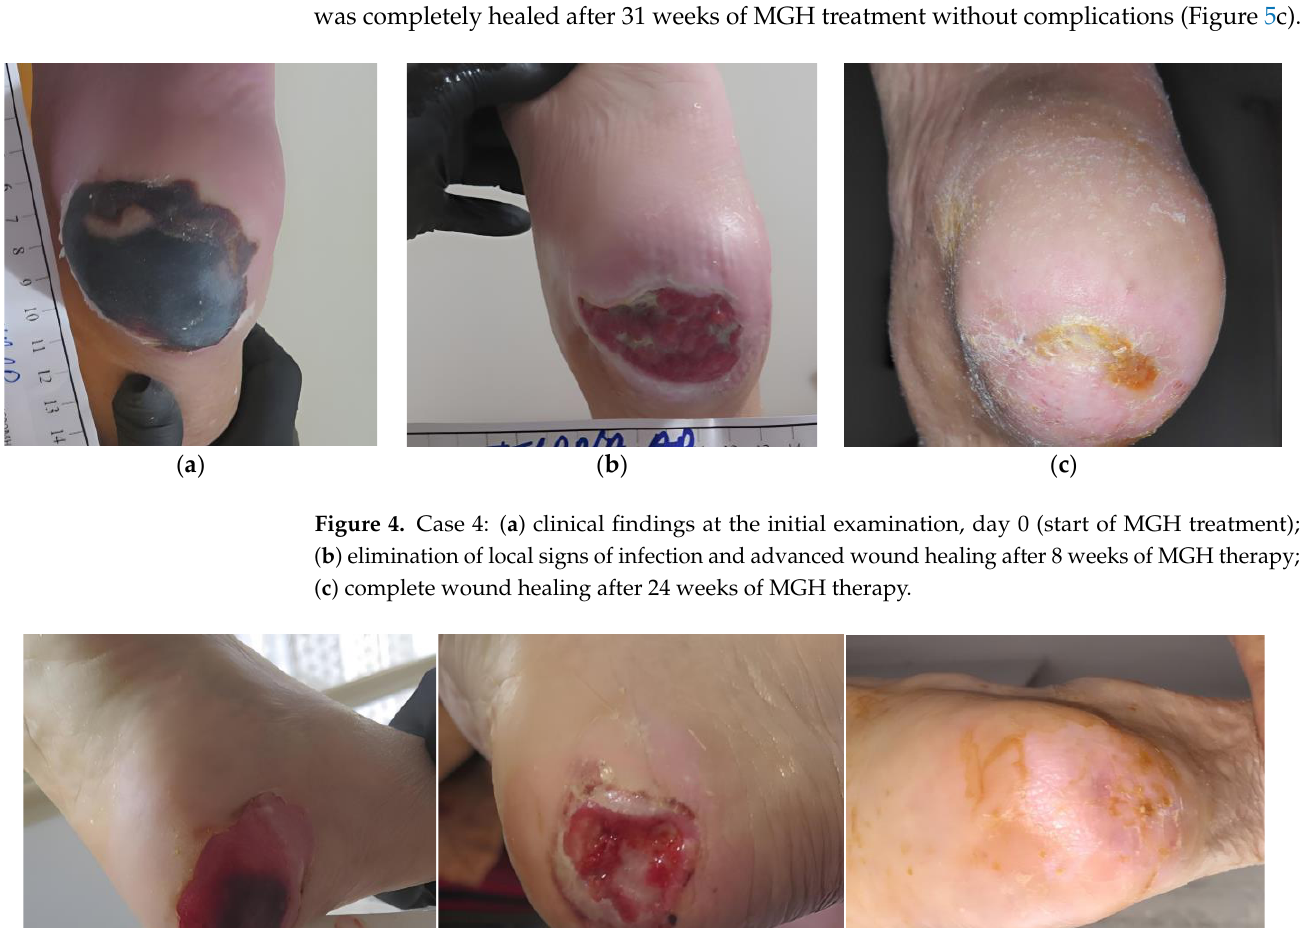
Figure 4. Case 4: ( a ) clinical findings at the initial examination, day 0 (start of MGH treatment); ( b ) elimination of local signs of infection and advanced wound healing after 8 weeks of MGH therapy; ( c ) complete wound healing after 24 weeks of MGH therapy.